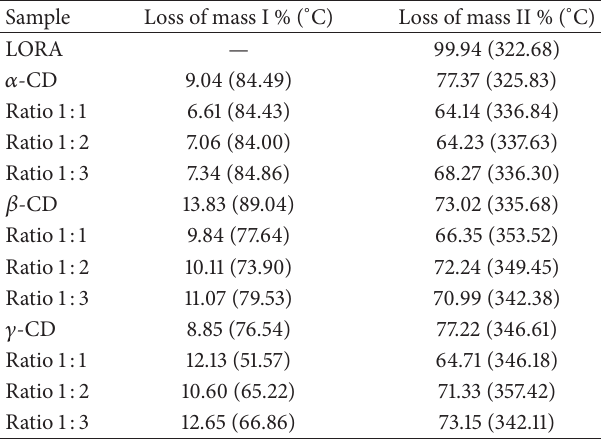
125.89 ∘ C (1 : 1), 134.87 ∘ C (1 : 2), and 125.31 ∘ C (1 : 3) shown